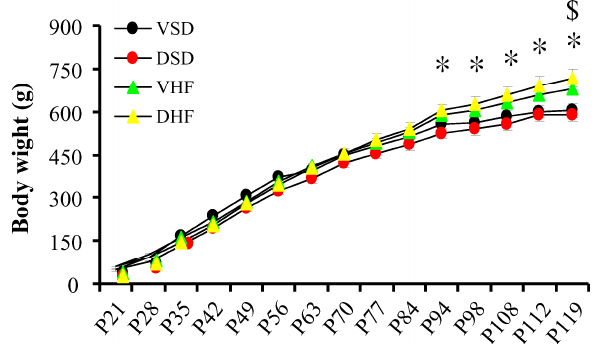
Figure 1. Body weights. Mean body weight from weaning until six months. Groups were compared by repeated measures Analysis of Variance (ANOVA) with post hoc least significant difference testing. *, vehicle with normal diet (VSD) group vs. vehicle and high-fat diet (VHF) group, p < 0.05; $, dexamethasone and normal diet (DSD) group vs. dexamethasone and high-fat diet (DHF) group, p < 0.05.